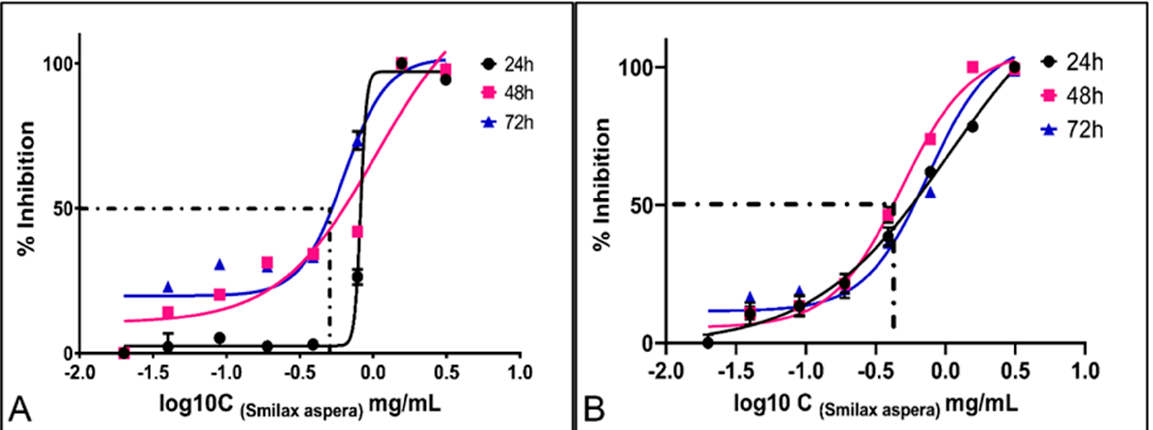
Figure 4. IC 50 of S. aspera extract on TE671 cells ( A ) and A172 cells at 24, 48 and 72 h ( B ). The lowest IC 50 value for TE671 cell line was 0.629 mg/mL, calculated at 72 h and 0.482 mg/mL for A172 cell line, calculated at 48 h. Cancer cell viability increases as concentration of the drug decreases.